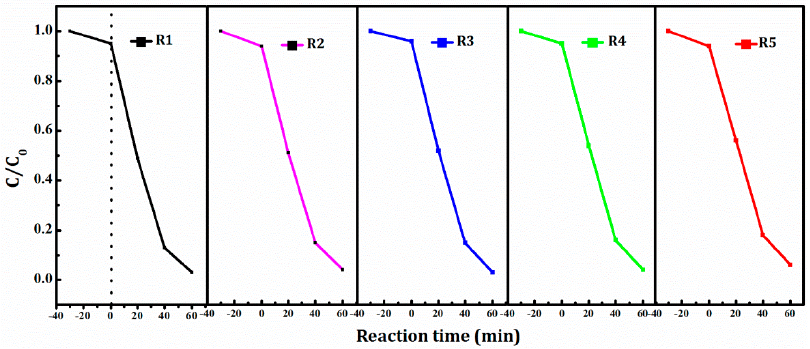
Figure 8. Cycling tests of Ag/BiVO 4 /Mn 1 − x Zn x Fe 2 O 4 .